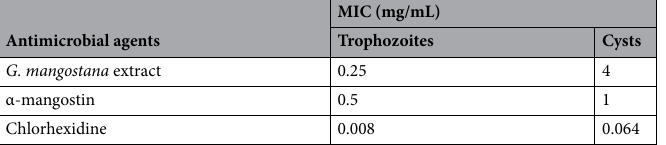
Antimicrobial agents